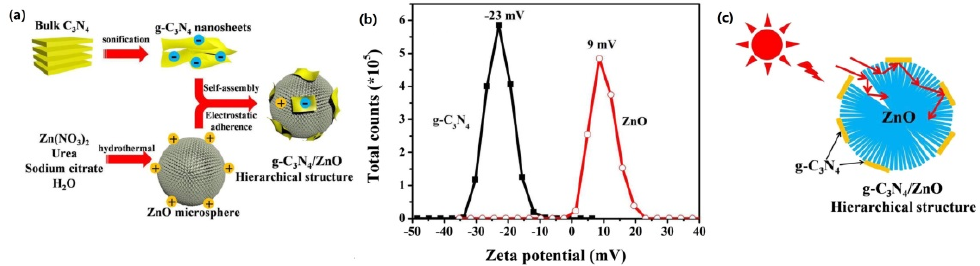
Figure 17. ( a ) Schematic diagram of synthesizing g − C 3 N 4 /ZnO microspheres; ( b ) zeta potential of ZnO and g − C 3 N 4 (pH = 7); ( c ) illustration of enhanced reflections within the g − C 3 N 4 /ZnO photo- catalyst. Used with permission from [173]. Copyright 2018